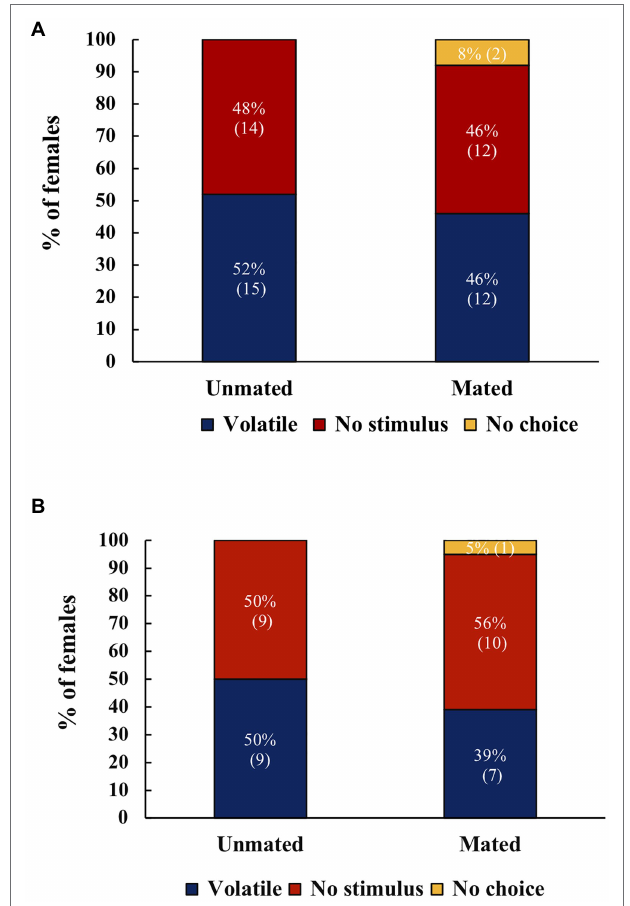
FIGURE 2 | (A) Response of unmated or mated A. ludens females to host volatiles or no stimulus in the morning ( N = 29 for unmated, N = 26 for mated). (B) Response of unmated or mated A. ludens females to host volatiles or no stimulus at dusk ( N = 18 for unmated, N = 18 for mated). There were no significant differences. Numbers within parenthesis represent sample